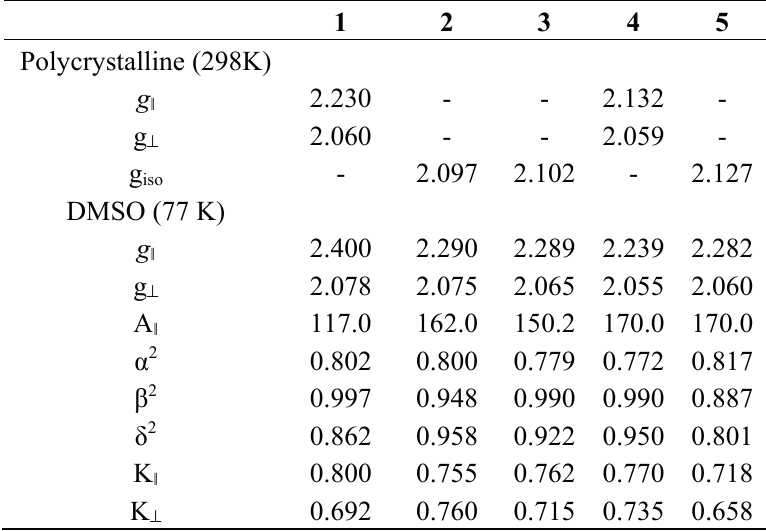
Table 4. EPR spectral parameters of the copper(II) complexes 1 – 5